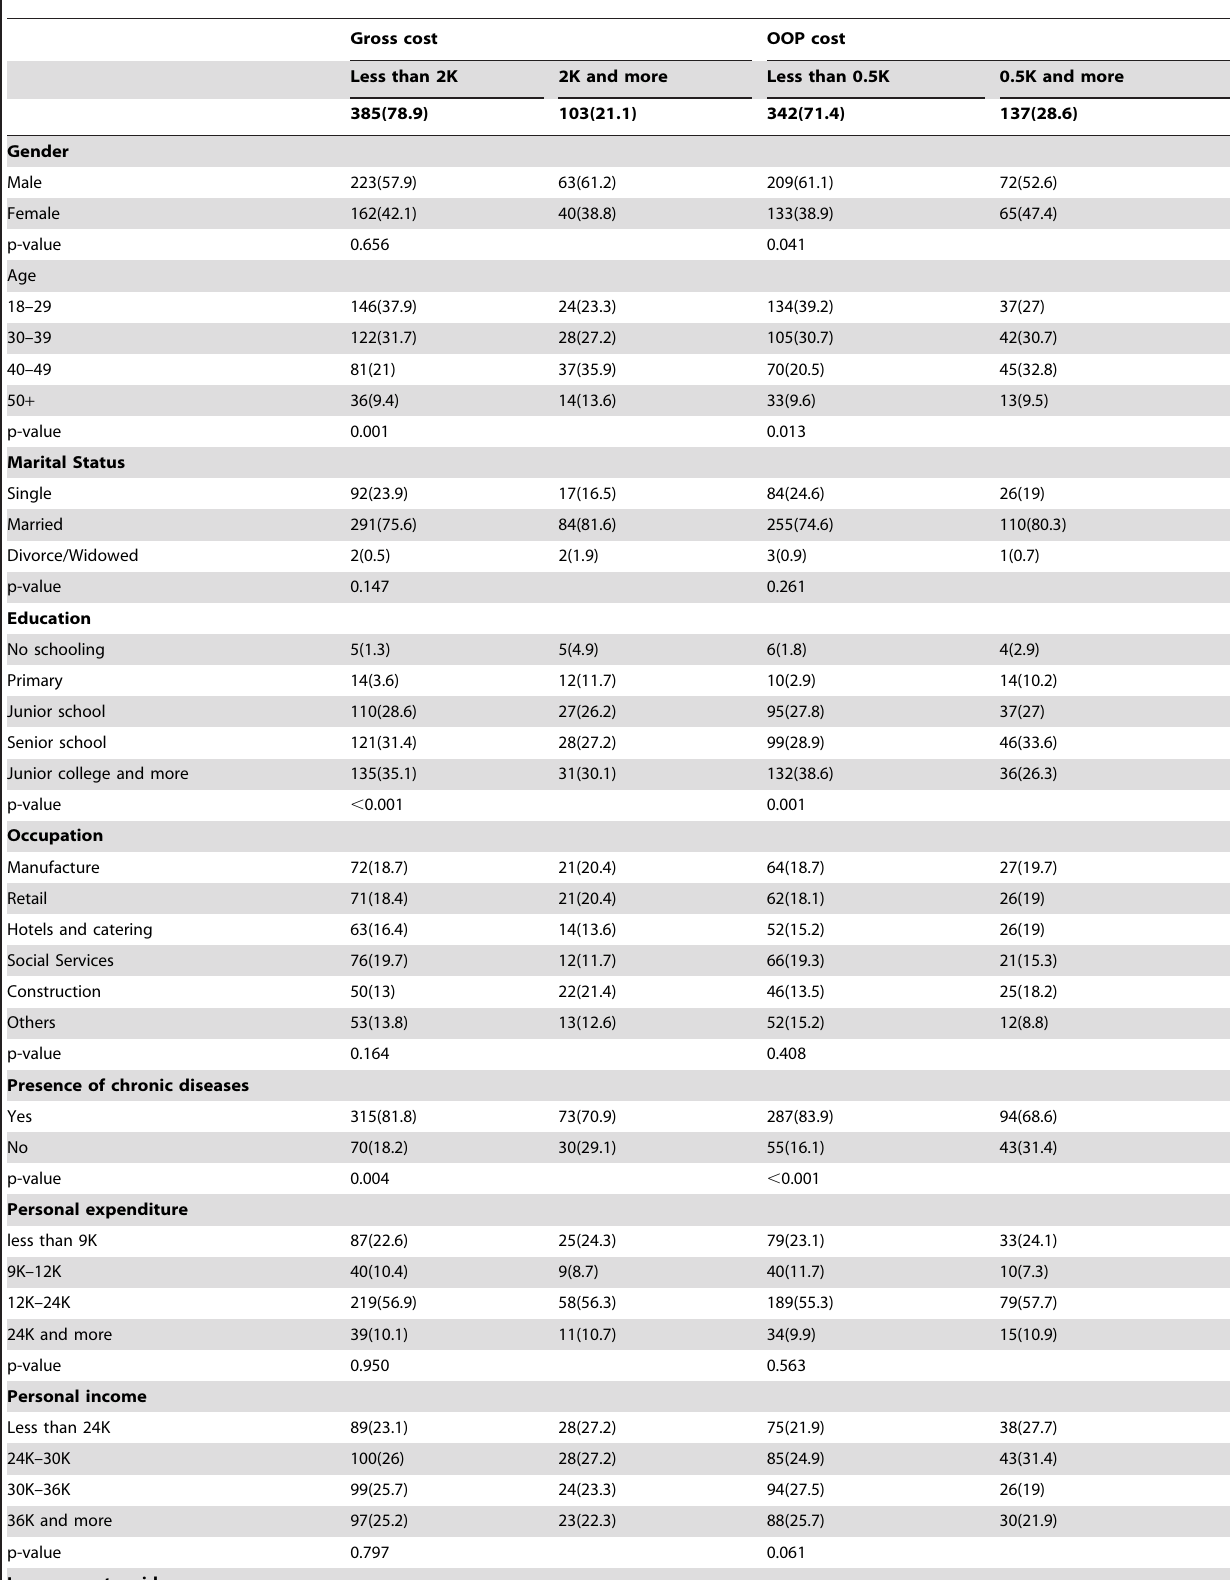
Table 3. Characteristics of subjects with different gross and OOP medical cost